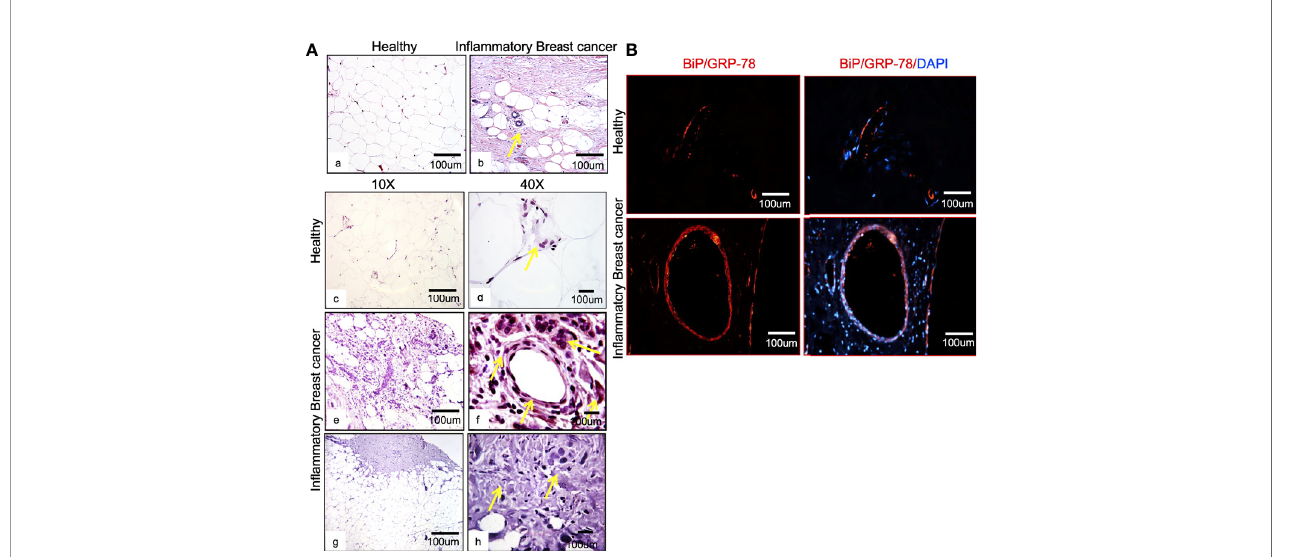
FIGURE 1 | BiP/GRP78 is expressed abundantly in human IBC tissue sections. (A) Hematoxylin and Eosin (H & E) staining of healthy (left) (Aa) and IBC tissue (right) (Ab) is shown at 10X and 40X magni fi cation. Healthy (Ac, Ad) and IBC tissue sections (Ae, Af) were stained using an antibody against BiP/GRP78. Human IBC tissue sections (Ag, Ah) were stained using an anti-IgG antibody. (Aa – Ac, Ae, Ag) are 10X, whereas (Ad, Af, Ah) represent 40X magni fi cation. (B) BiP/GRP78 immunostaining (red) and healthy and IBC tissue are shown at 10X magni fi cation. Tissue sections were developed with Alexa-594 coupled secondary antibody (red). Nuclei were visualized using DAPI as the counterstain